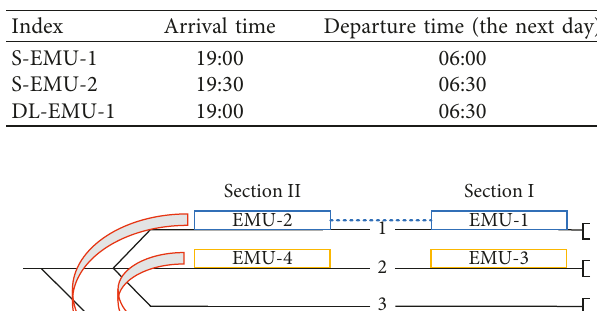
Table 2: The schedule of the two S-EMUs and the generated DL- EMU.